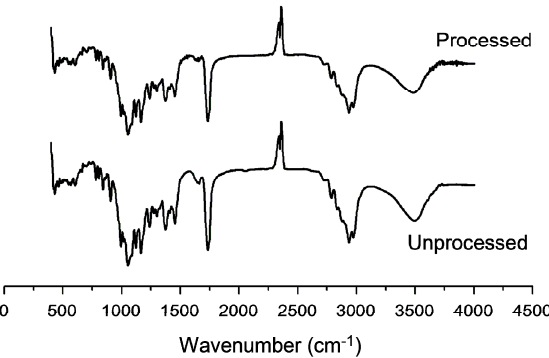
Figure 5. FTIR spectra of unprocessed and processed spiramycin (spiramycin microparticles are the micronized spiramycin by homogenate-antisolvent precipitation under optimum conditions).